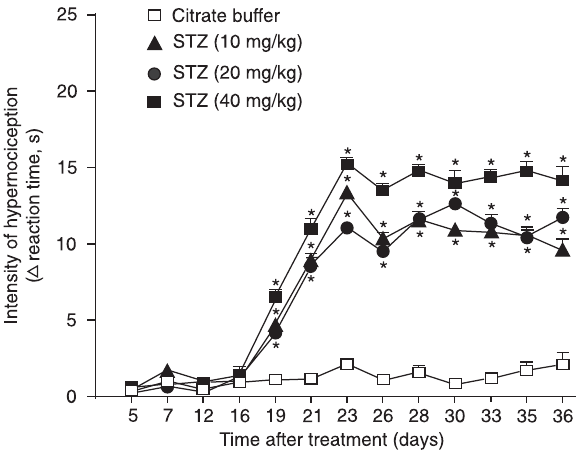
Figure 2. Mechanical hypernociception induced by iv adminis- tration of streptozotocin (STZ). Mechanical hypernociception was evaluated on the days indicated after iv administration of vehicle (control group; citrate buffer, 10 mM, pH 4.5, equivalent volume) or STZ (10, 20 or 40 mg/kg). Data are reported as means ± SEM for groups of 6 rats. *P < 0.05 compared to citrate buffer-treated rats (ANOVA followed by the Bonferroni